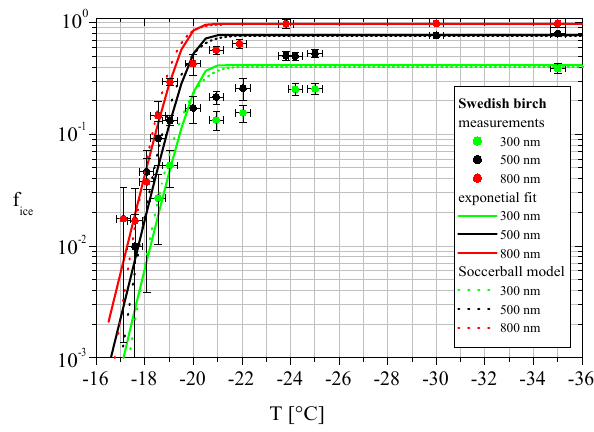
Fig. 8. Ice fraction f ice as a function of temperature T for 300, 500 and 800nm Swedish birch pollen washing water particles (dots) and model calculations for the different sizes (lines) assuming only one INA macromolecule to be present in the Swedish birch pollen sample. The mean square errors between the measured and the cal- culated ice fraction for the 300, 500 and 800nm particles showed values of 7 . 22, 14 . 47 and 2 . 58 for the simple exponential fit of J het and 6 . 19, 14 . 70 and 2 . 50 for the SBM, respectively.